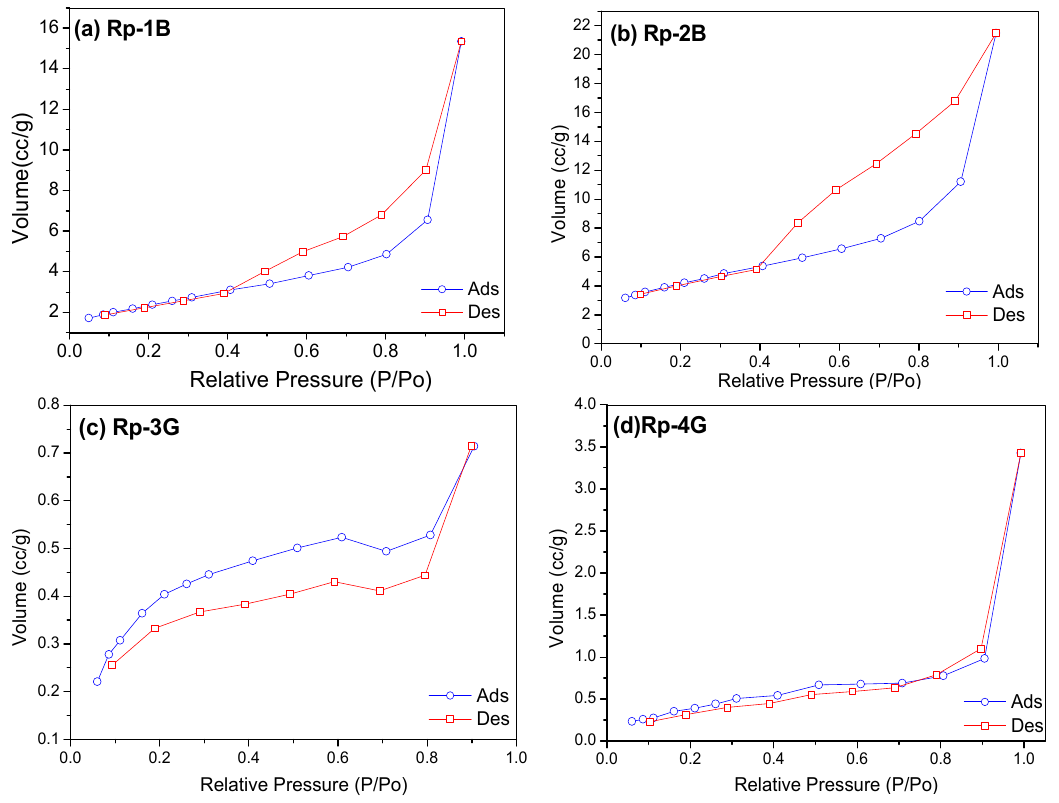
Figure 2. N 2 adsorption and desorption isotherms: ( a ) Rp-1B, ( b ) Rp-2B, ( c ) Rp-3G and ( d ) Rp-4G.